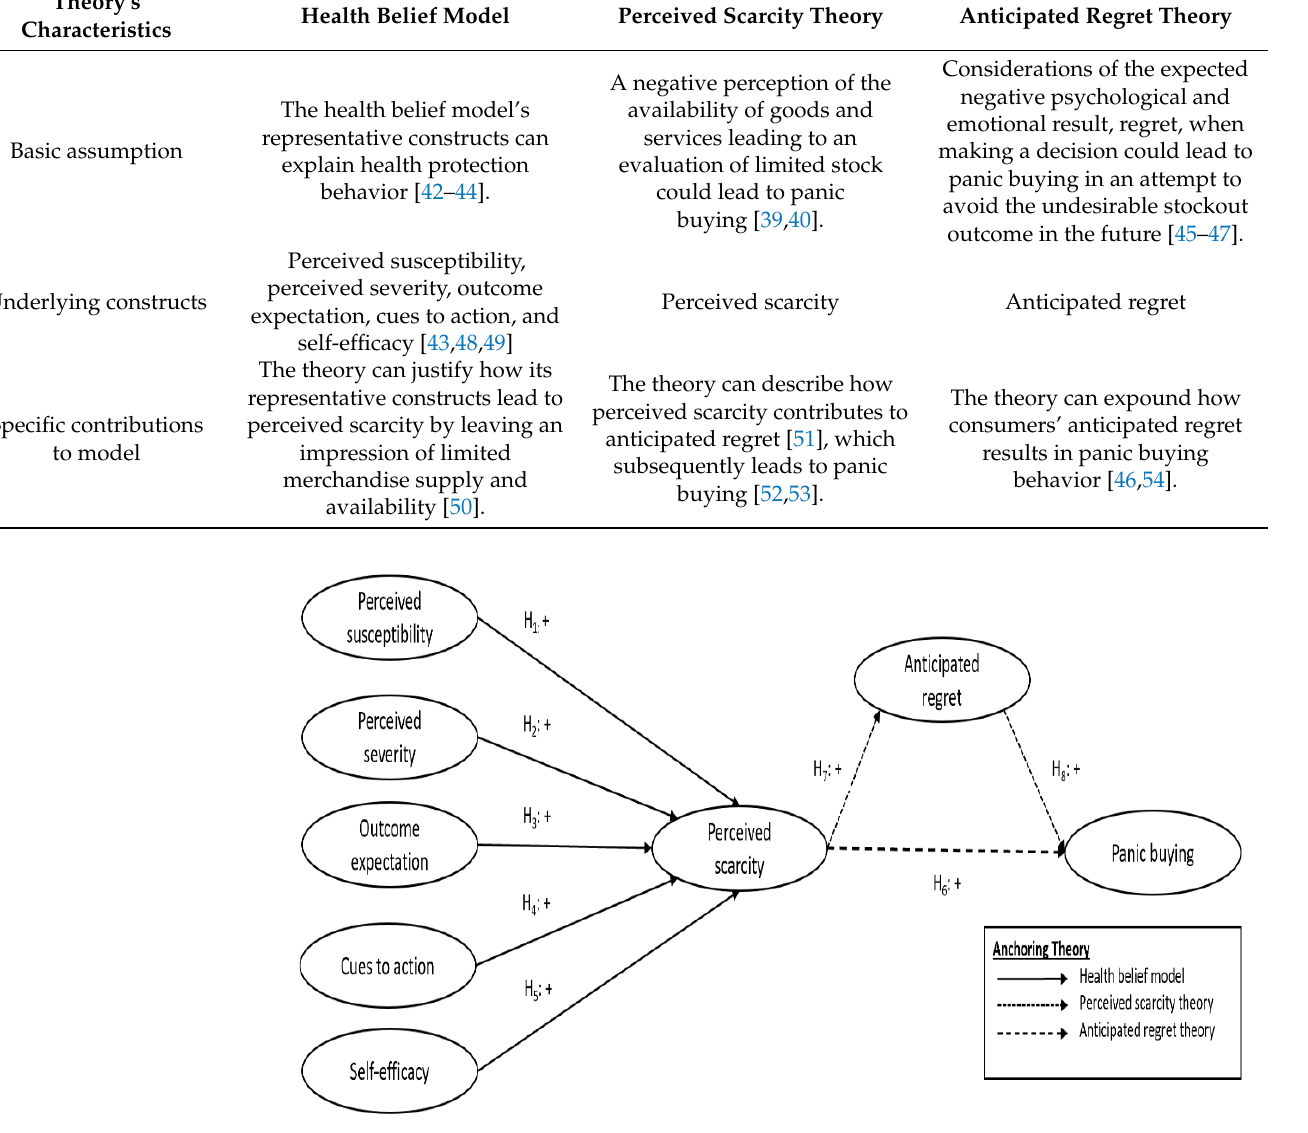
Figure 1. The proposed structural equation model.